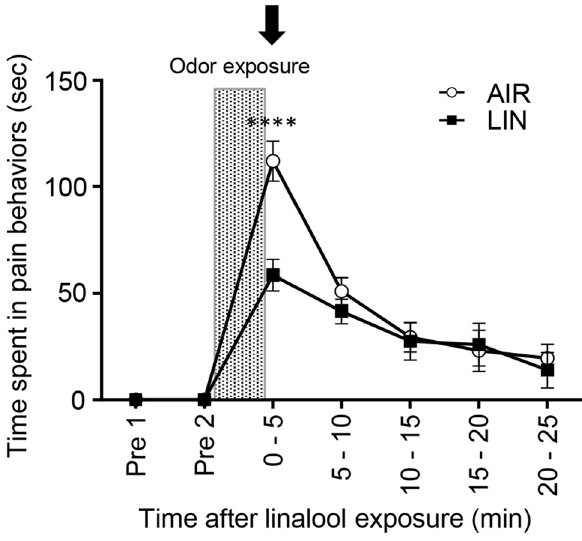
Figure 3. Five minutes of linalool odor exposure induced a sustained 5-min analgesic effect in the tail capsaicin test. Plots indicate the cumulative time spent in pain behaviors for every 5 min. n = 8 for both odorless-air exposed mice (AIR) and linalool-exposed mice (LIN). The shaded area indicates odor exposure. Arrow indicates the timing of capsaicin injection to the tail. Values are represented as mean ± SEM. **** p < 0.0001 (Sidak’s multiple comparison